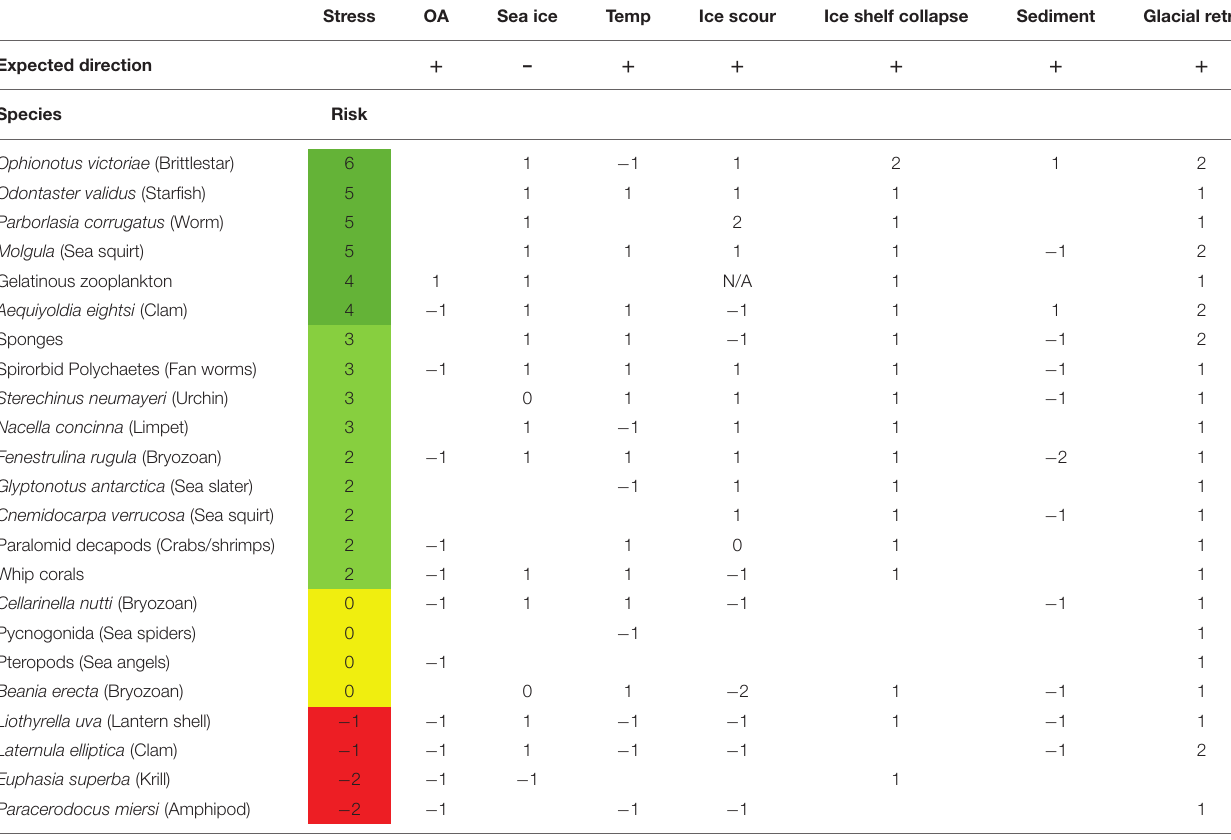
TABLE 3 | Risk assessment matrix for Polar marine invertebrate taxa. Stress OA Sea ice Temp Ice scour Ice shelf collapse